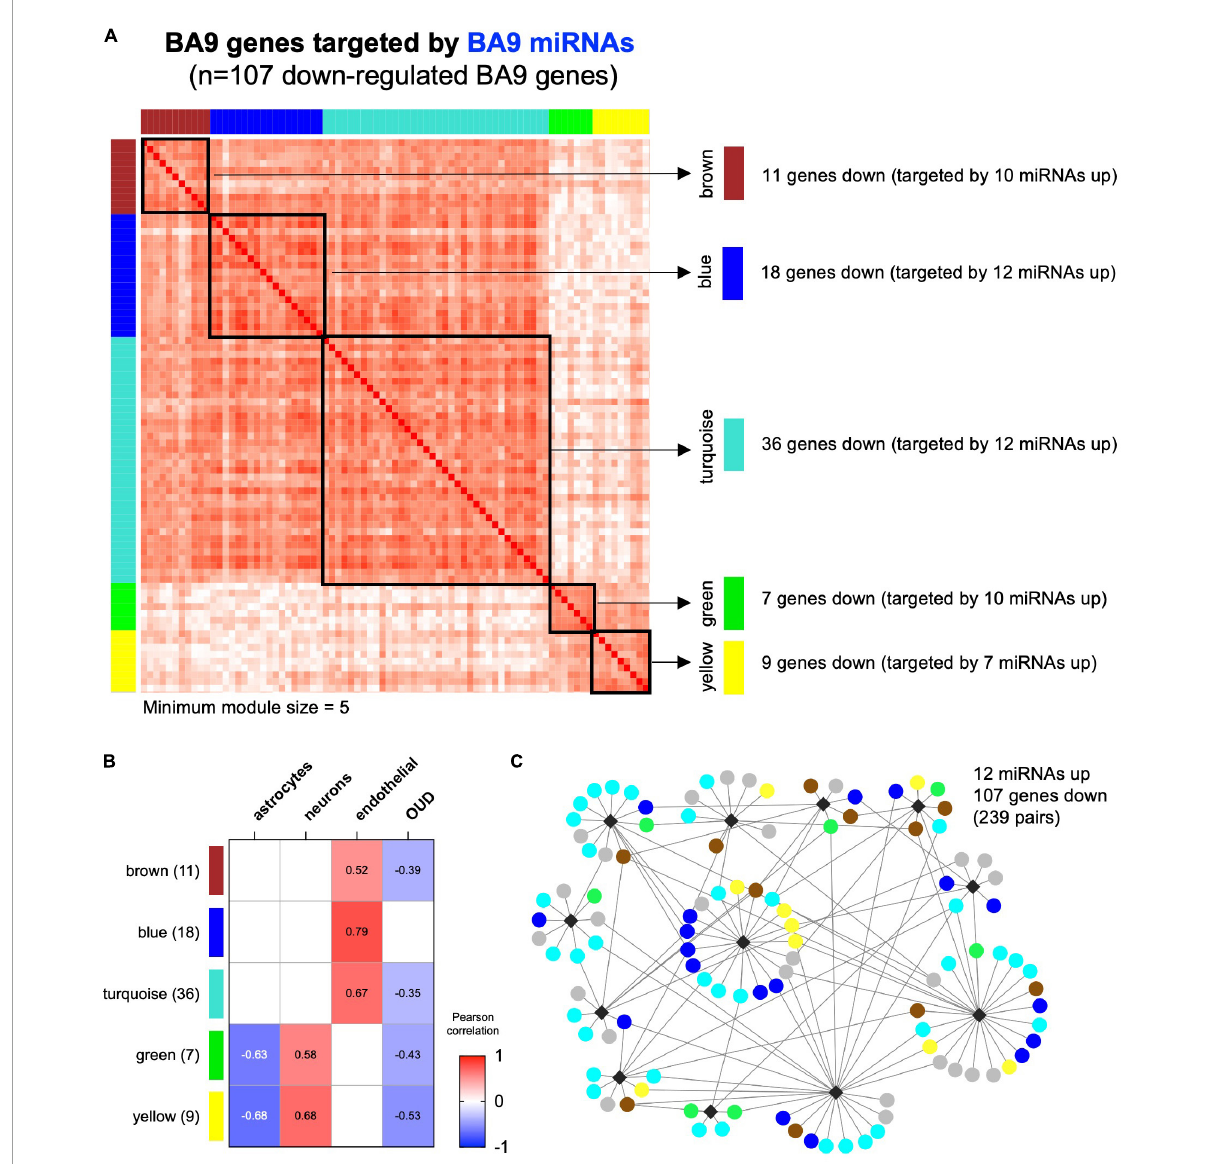
FIGURE5 Correlation-based analysis of BA9 canonical miRNA–mRNA network genes. (A) Weighted gene correlation network analysis (WGCNA) was carried out for the 107 BA9 gene targets of BA9 miRNAs, identifying five distinct gene modules using a minimum module size of 5. The gray module of 26 uncorrelated genes was not included. (B) Association with brain cell type abundance (astrocytes, neurons, and endothelial cells) and OUD diagnosis was evaluated for each module. (C) Module membership is indicated in the network comprised of increased miRNAs and decreased genes, indicating the turquoise, blue, brown, green, and yellow WGCNA module